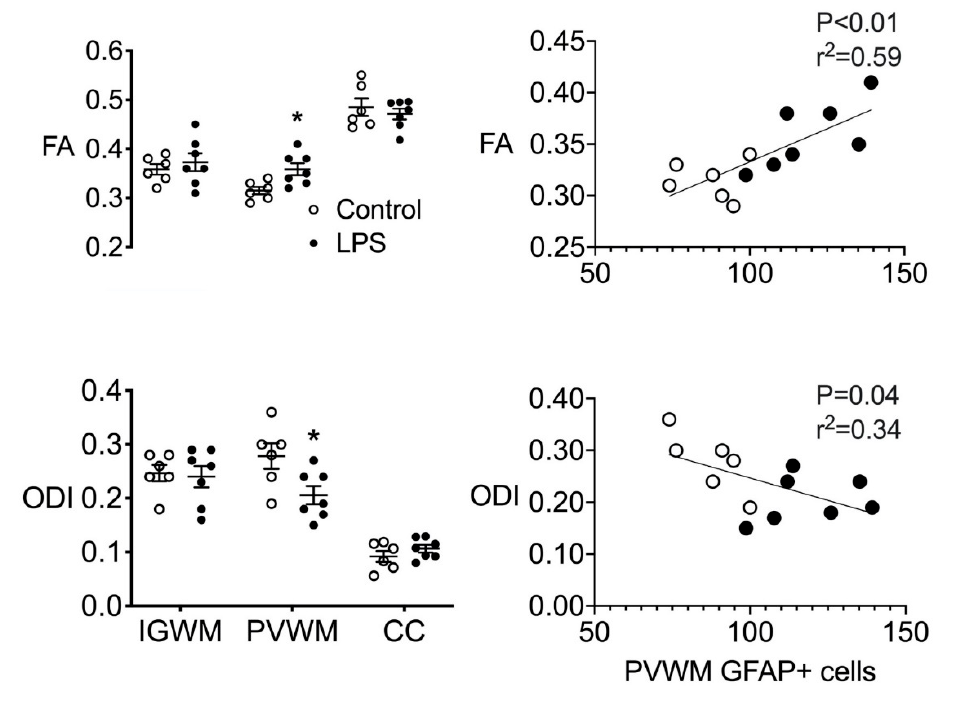
Figure 4. Diffusion tensor magnetic resonance imaging (MRI). ( Left ) Fractional anisotropy (FA) and orientation dispersion index (ODI) in the intragyral and periventricular white matter (IGWM and PVWM, respectively) and corpus callosum (CC) in control (open bars, n = 6) and LPS groups (closed bars, n = 7). ( Right ) Correlative analysis between FA, ODI, and periventricular GFAP-positive astrocytes in control (open circles, n = 6) and LPS groups (closed circles, n = 7). * p < 0.05, LPS vs. control.